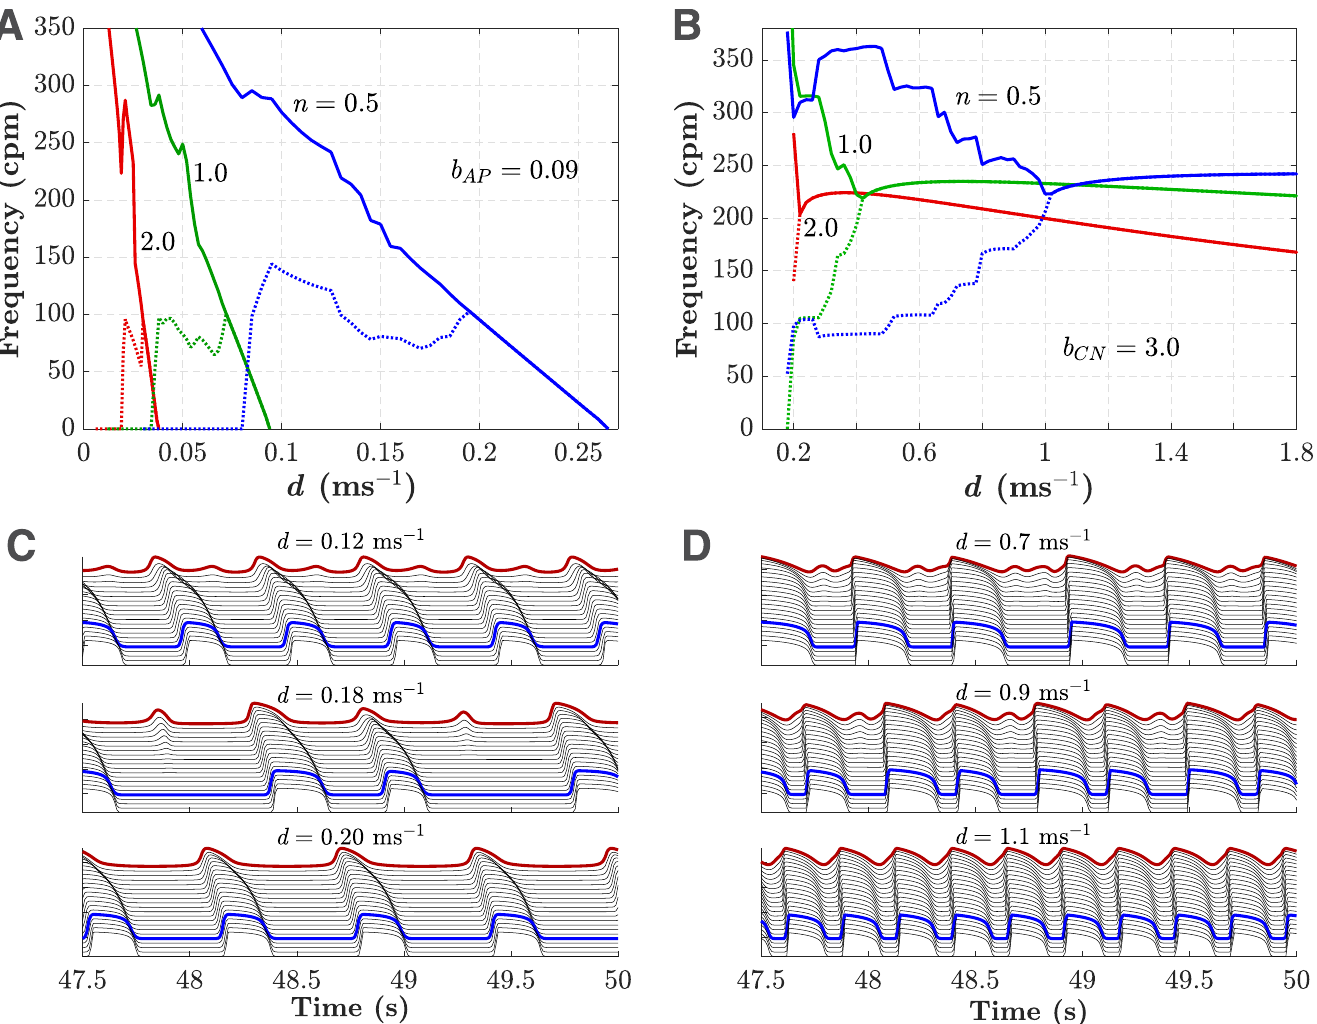
Fig 7. Synchronization in the simplified 1D coupled model systems with fixed parameters b . Dependence of synchronization in the pAP-AP (A) and pCN-CN (B) systems with a different number of excitable cell strands n on the coupling parameter d . Solid lines correspond to the pacemaker frequency and the dotted lines—to the frequency at the 16th excitable cell in the strand(s). C. Action potentials for the pAP-AP system for the number of strands n = 0.5. The bold red and blue lines mark the action potentials of the pacemaker cell and 16th cell of a strand, respectively. D. The same as in panel C, but for the pCN-CN system.